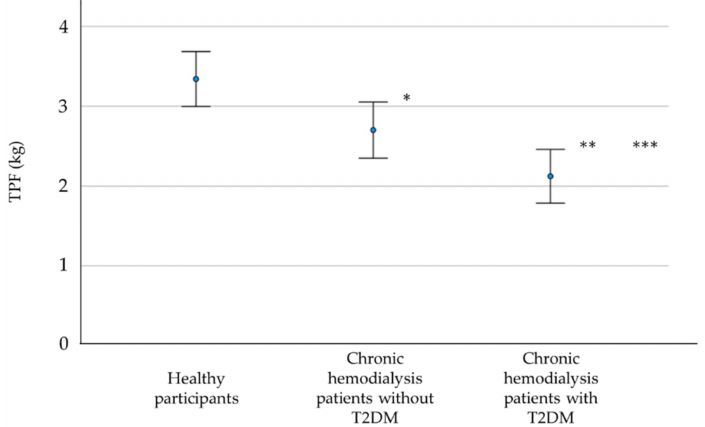
Figure 1. Comparison of toe pinch force (TPF) among healthy participants and chronic hemodialysis patients with and without type 2 diabetes mellitus (T2DM). Healthy participants vs. Chronic hemodialysis patients without T2DM, * p = 0.025; Chronic hemodialysis patients without T2DM vs. Chronic hemodialysis patients with T2DM, ** p = 0.042; Healthy participants vs. Chronic hemodialysis patients with T2DM, *** p <